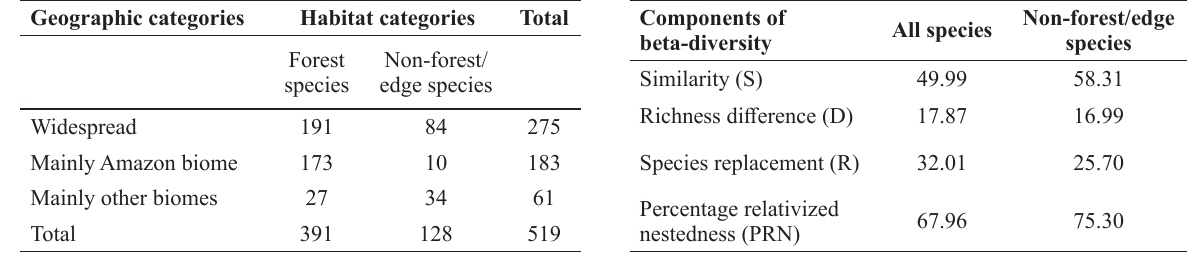
Percentage contribution of each component of beta- diversity for two groups of birds recorded in cangas vegetation in the Carajás National Forest.